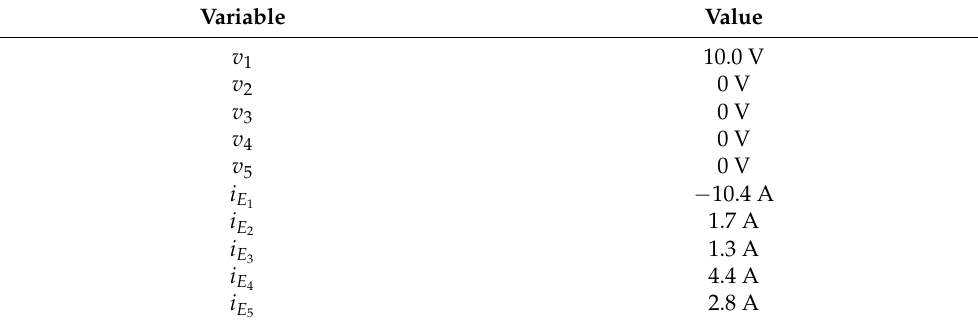
Table 2. Summary of voltages and